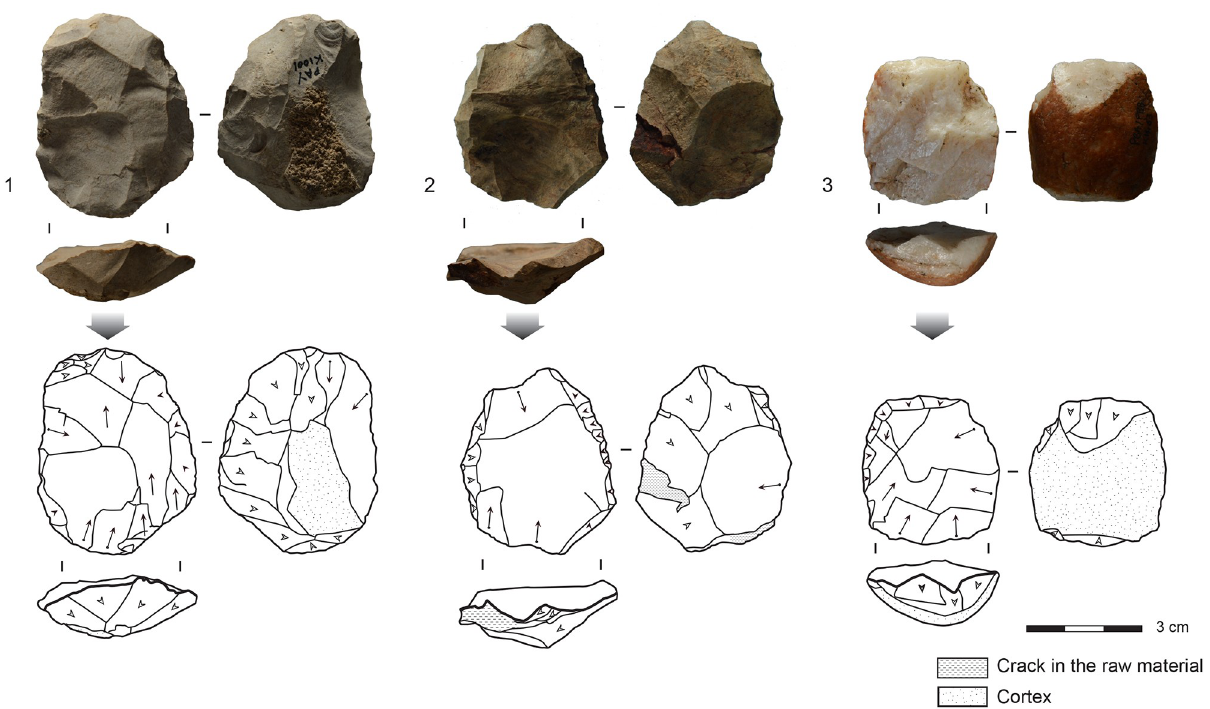
Fig 6. Examples of Levallois cores from the KDS sequence. 1–2: layer PAY, Silcrete. 3: layer PBA/PBB, Quartz.